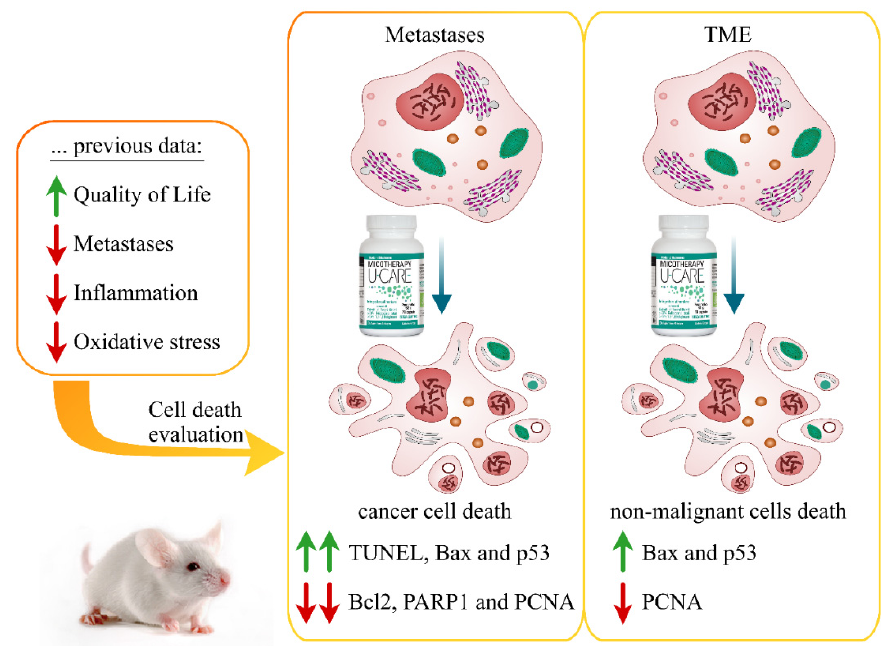
Figure 1. Graphic illustration underlining the main results.